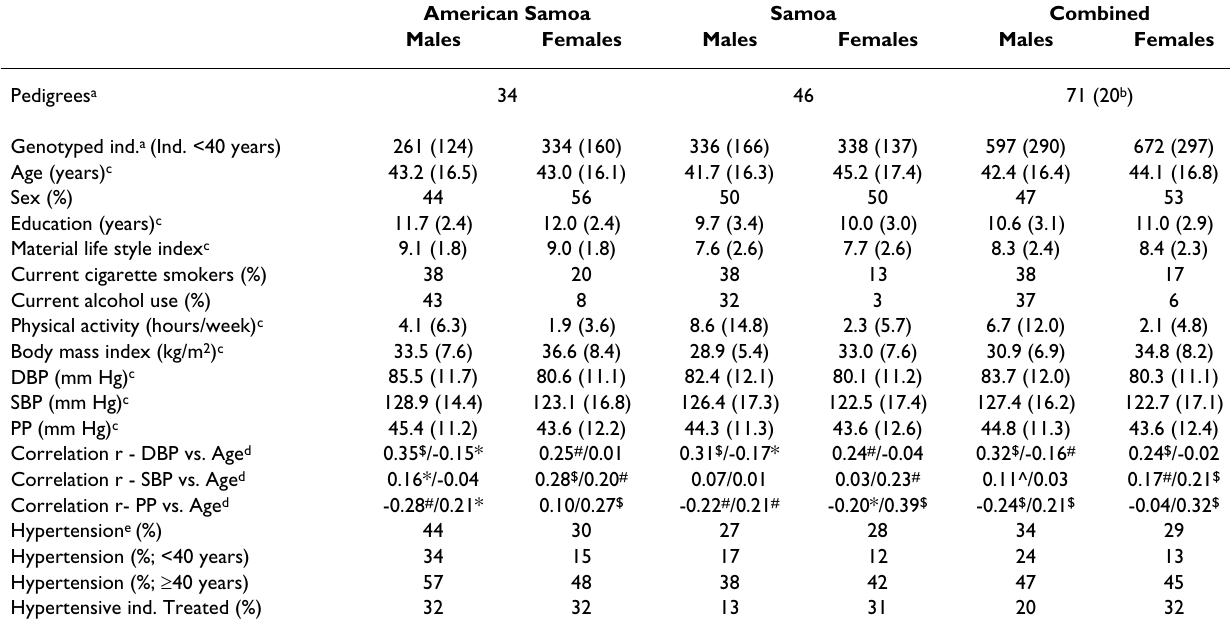
Table 1: Description of Sample - non-transformed